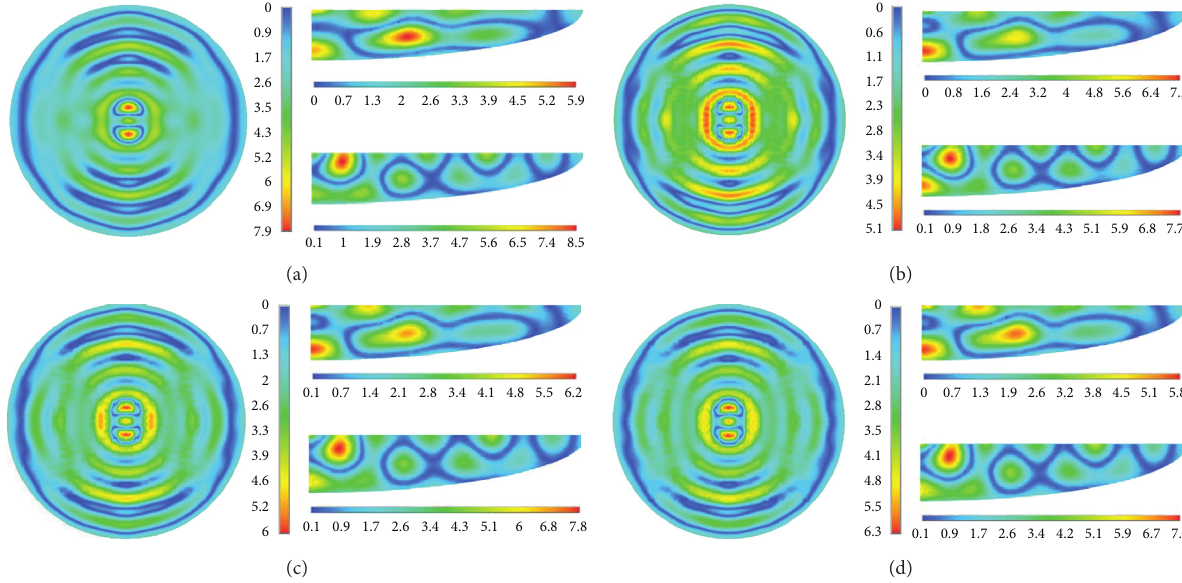
Figure 14: The displacement amplitude of the homogeneous sedimentary basin ( f � 2.0Hz): (a) no buildings; (b) D � 55m; (c) D � 62.5m; (d) D � 70 m.